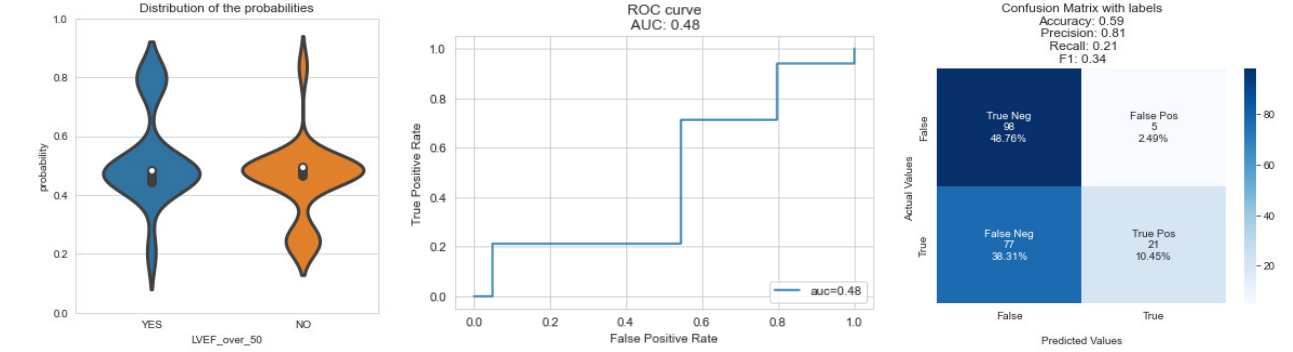
Figure 7. Classification results for diabetes variables.